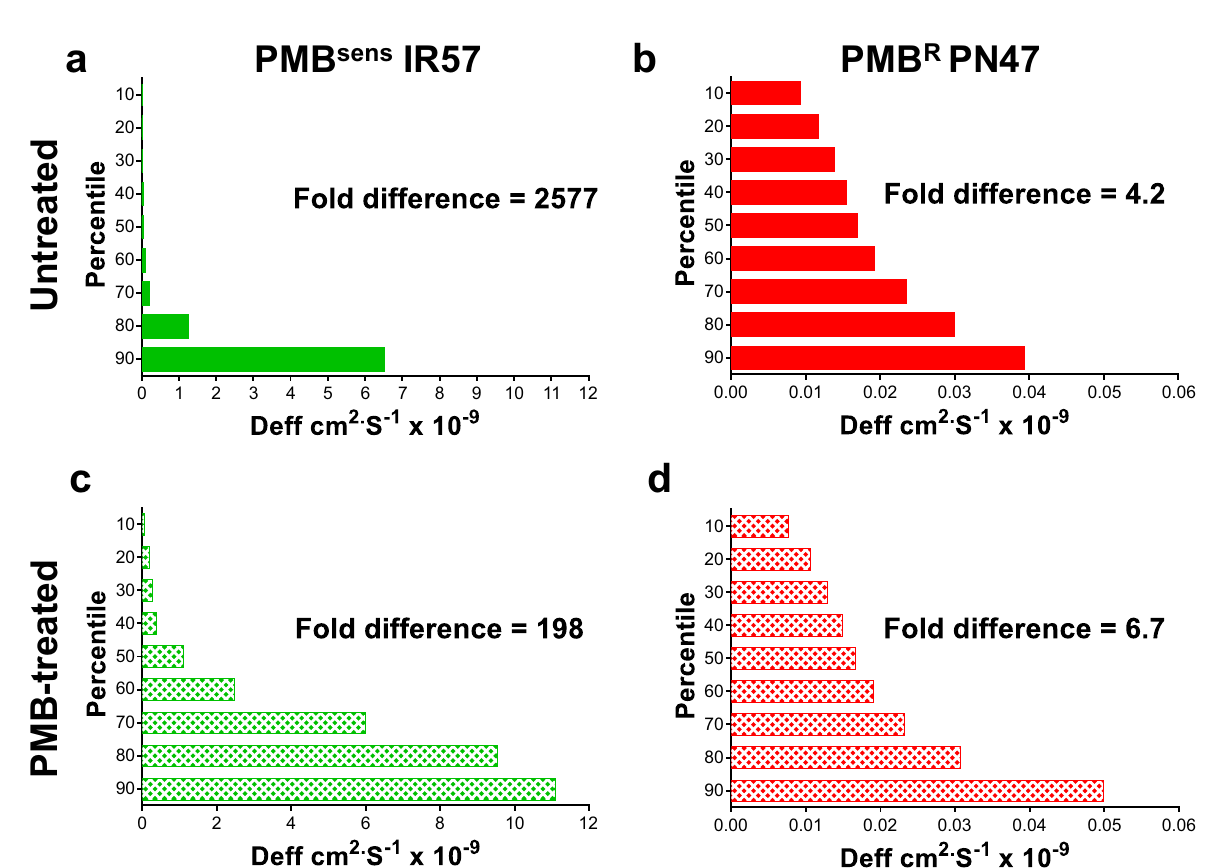
Fig. 6 Heterogeneity of NP movement through PMB Sens E. coli IR57 and PMB R E. coli PN47 bio fi lm structures ± Polymyxin B treatment. Heterogeneity of 200 nm negatively charged carboxylate-modi fi ed Fluo Spheres ® movement within E. coli bio fi lms. Untreated controls a PMB Sens E. coli IR57, b PMB R E. coli PN47. Polymyxin B (PMB; 8 µg/ml) treated bio fi lms, c PMB sens E. coli IR57, d PMB R E. coli PN47. For each particle type, the effective diffusion coef fi cient <Deff> was calculated for 360 individual particles ( n = 3 for bio fi lm experiments,